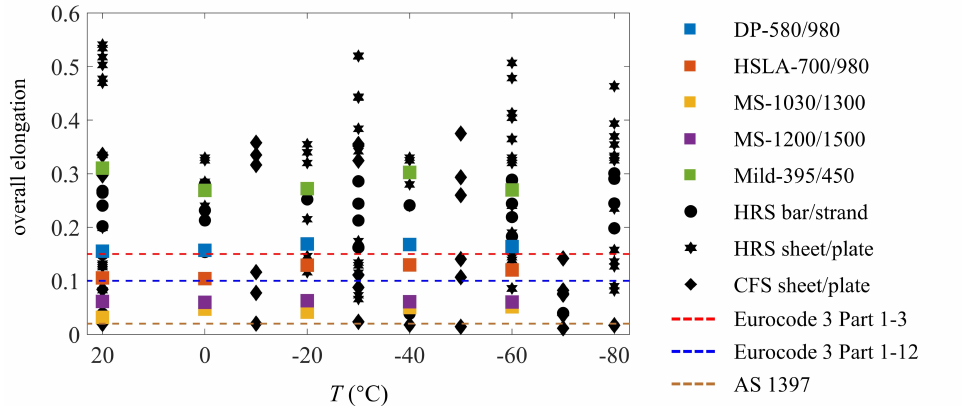
Figure 12. Overall elongations for AHSS, HSLA-700/980, Mild-395/450, and data from published experiments compared with current standard requirements